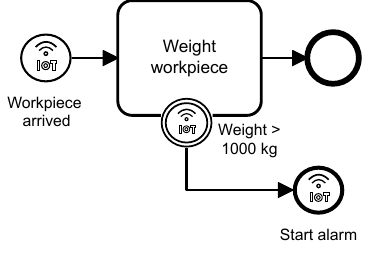
Figure 10. Usage of IoT Boundary, IoT Start and IoT End event.